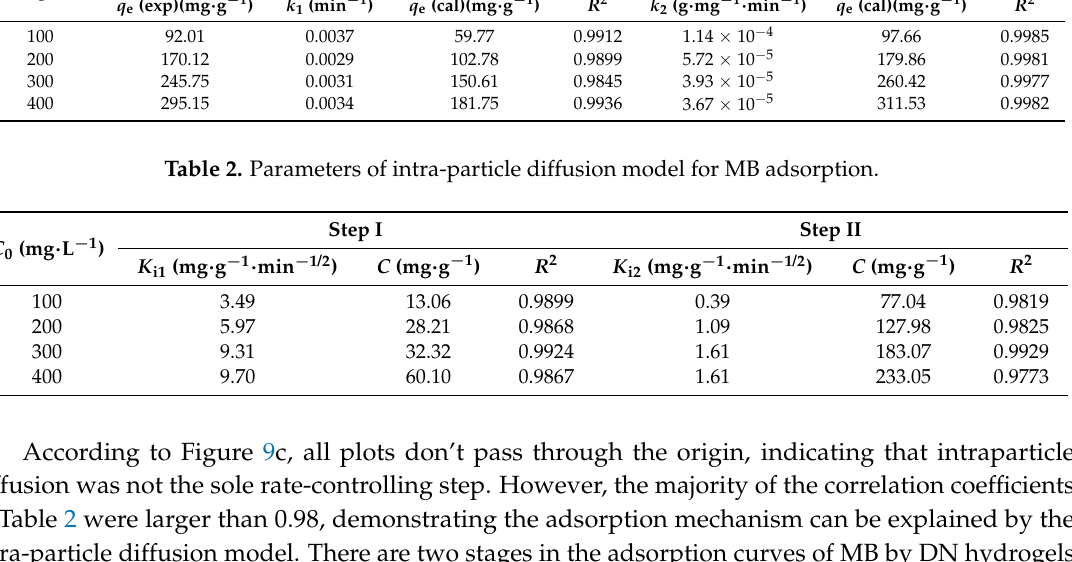
Table 1. Adsorption kinetic parameters of MB by adsorbents.